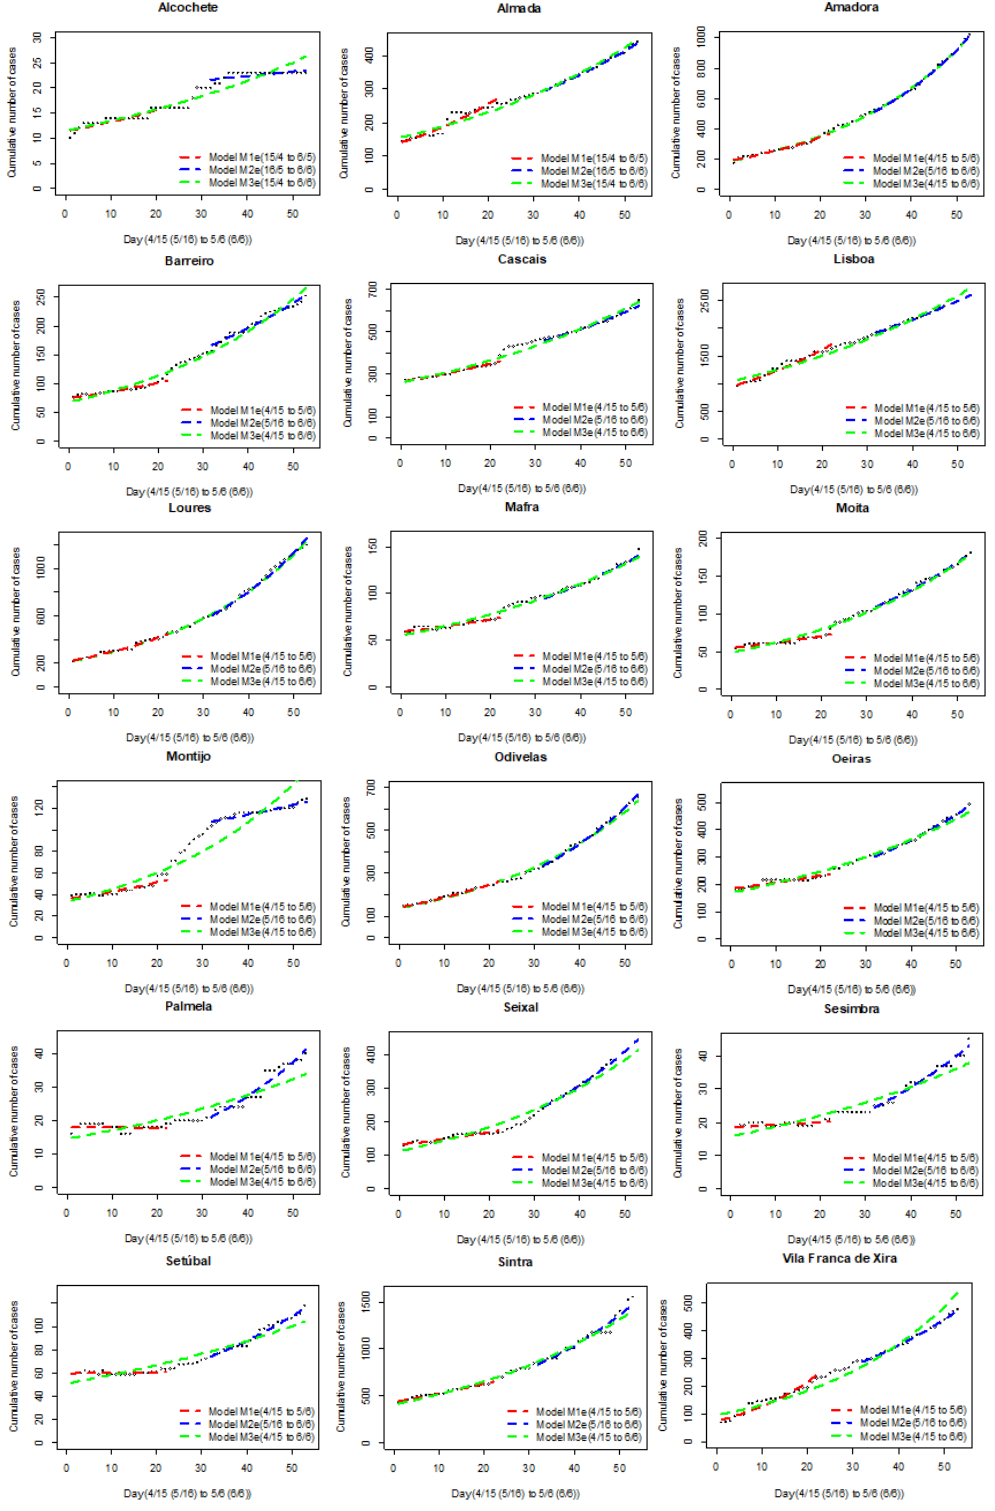
Figure A2. Exponential models adjusted to S 1 and S 3 segments and to the complete time